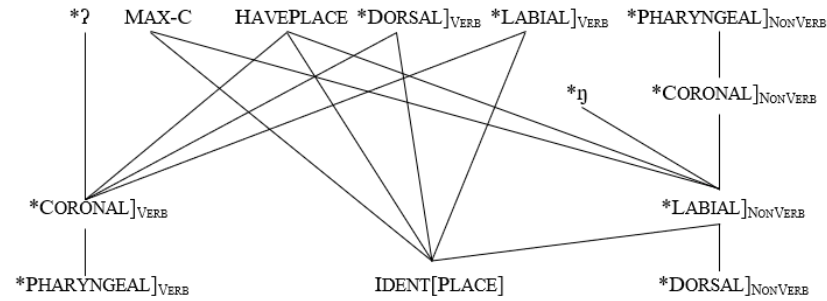
(79) Final ranking for PoA of latent segments in Shipibo-Konibo